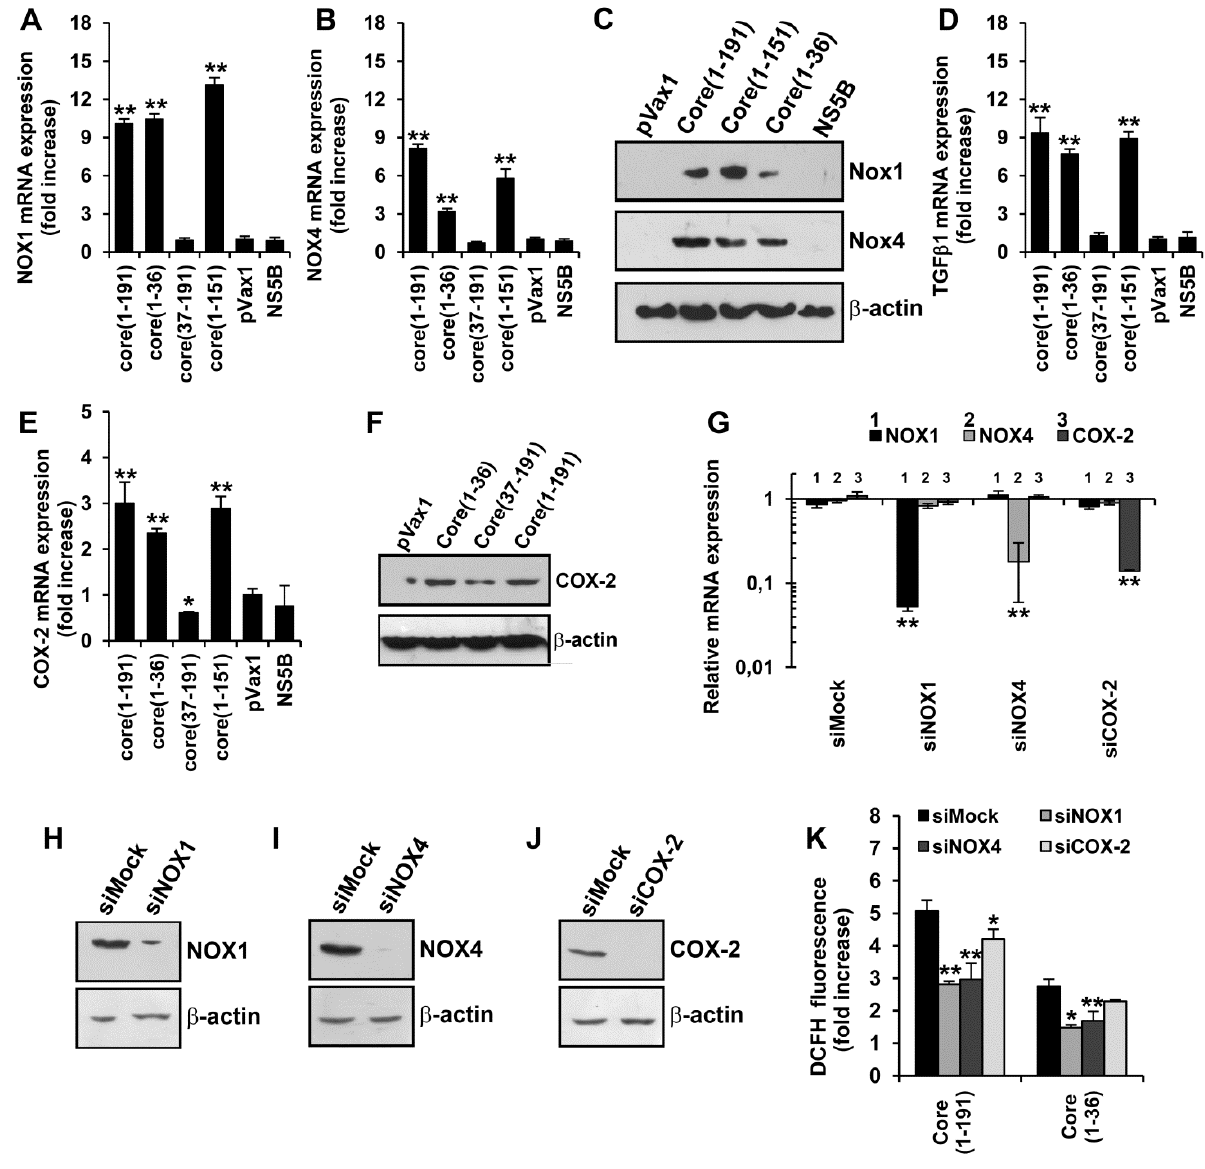
Figure 3. Cont Figure 3. Cont .